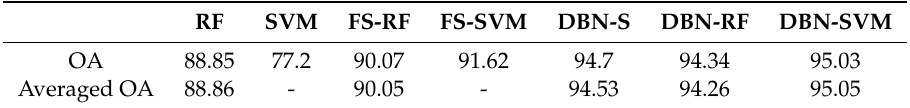
Table 11. Averaged overall accuracies (OAs) and those closer to those of Test 1 based on different models. RF: random forest. SVM: support vector machine. FS-RF: RF with feature selection (FS)